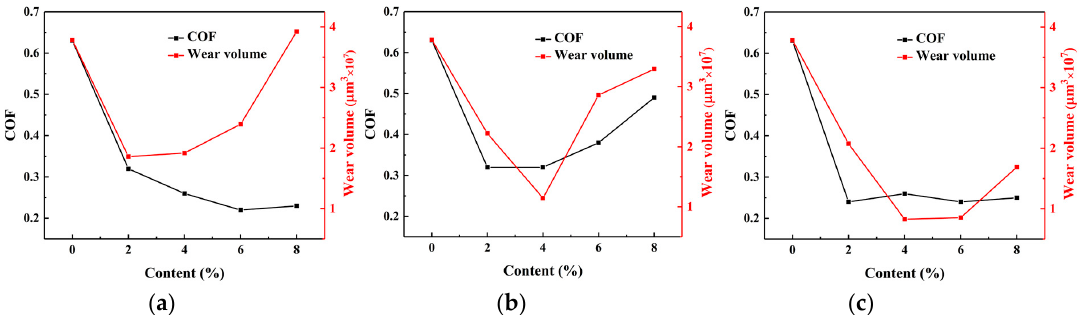
Figure 10. Comparison of wear and friction coefficient of composites with different additives. ( a ) MoS 2 , ( b ) H-CNTs, and ( c ) 6% MoS 2 +